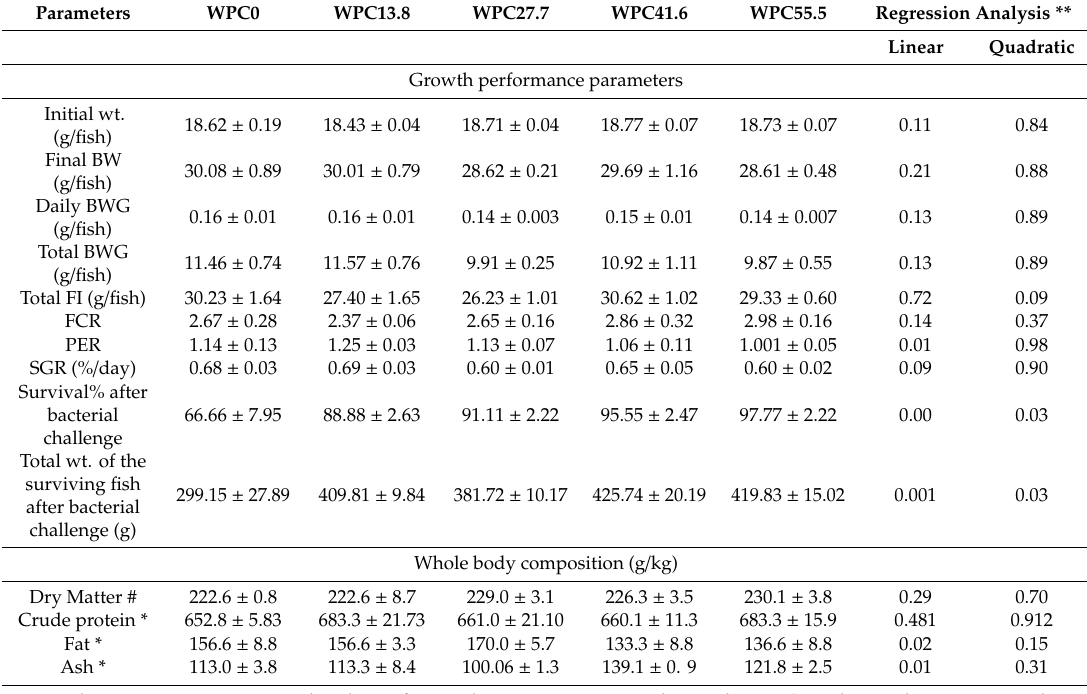
Table 2. The e ff ect of partial replacement of fish meal with whey protein concentrate on the growth performance and the whole body composition (g / kg) of Nile tilapia